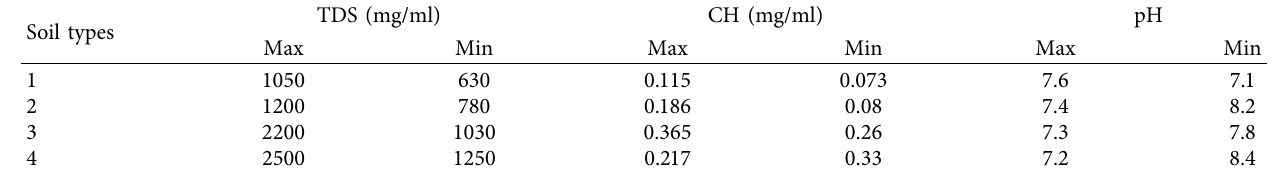
Figure 6: Relationship of the water leaching volume of untreated soil with (a) TDS and (b) calcium hardness (CH). Table 3: Results of chemical analysis of leachate from untreated soil